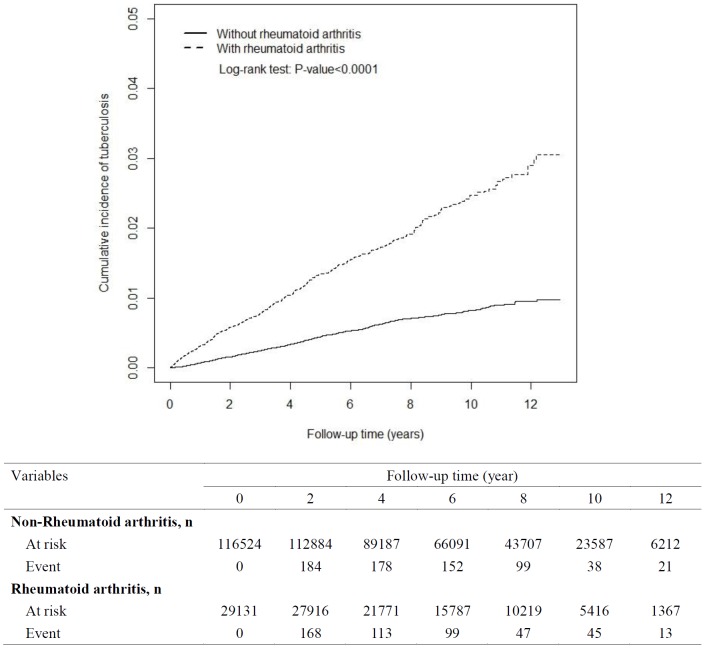
Cumulative incidence of active pulmonary tuberculosis for patients with rheumatoid arthritis (dashed line) and comparison subjects (solid line).